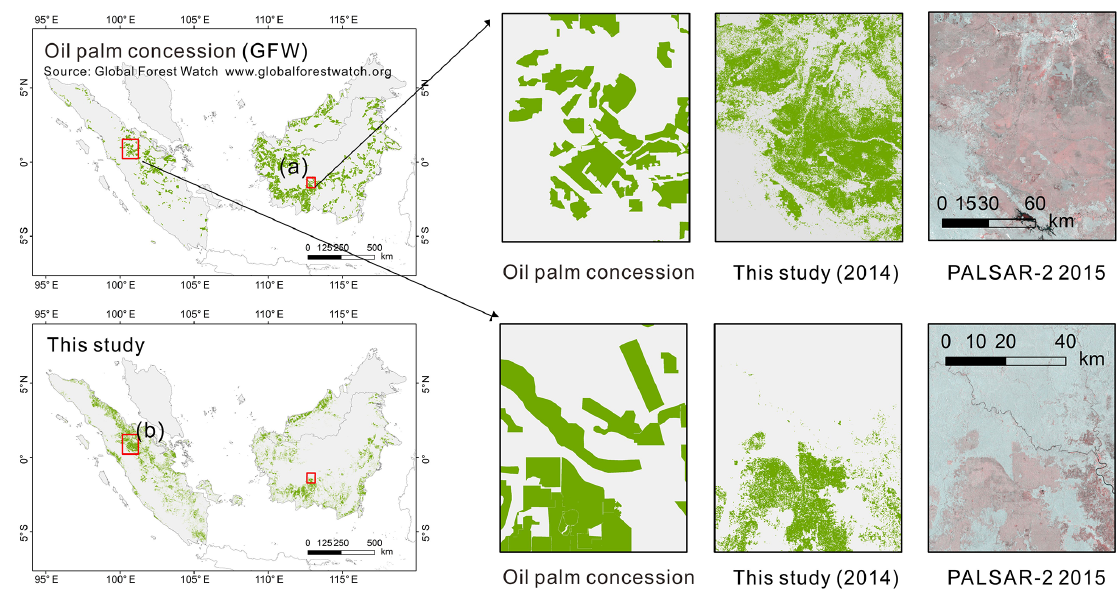
Figure 9. Comparison with oil palm concession from Global Forest Watch (GFW) for 2014. The PALSAR-2 images were composited in RGB format (HH, HV,